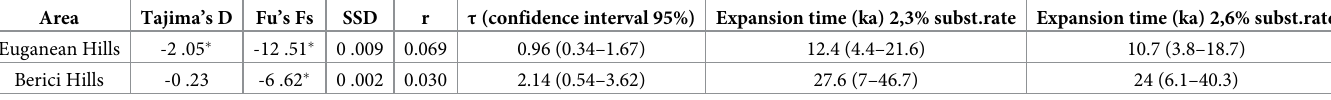
Tajima’s (D) and Fu’s neutrality test (Fs) mismatch distribution analysis under a sudden expansion model and time since expansion calculated for mitochondrial populations of the Euganean and Berici Hills considering the combined data base. SSD: sums of squared deviations; r: raggedness index, τ : age of expansion measured in units of mutational time. Expansion time shows as 1,000 years ago (ka). � Significant at p <